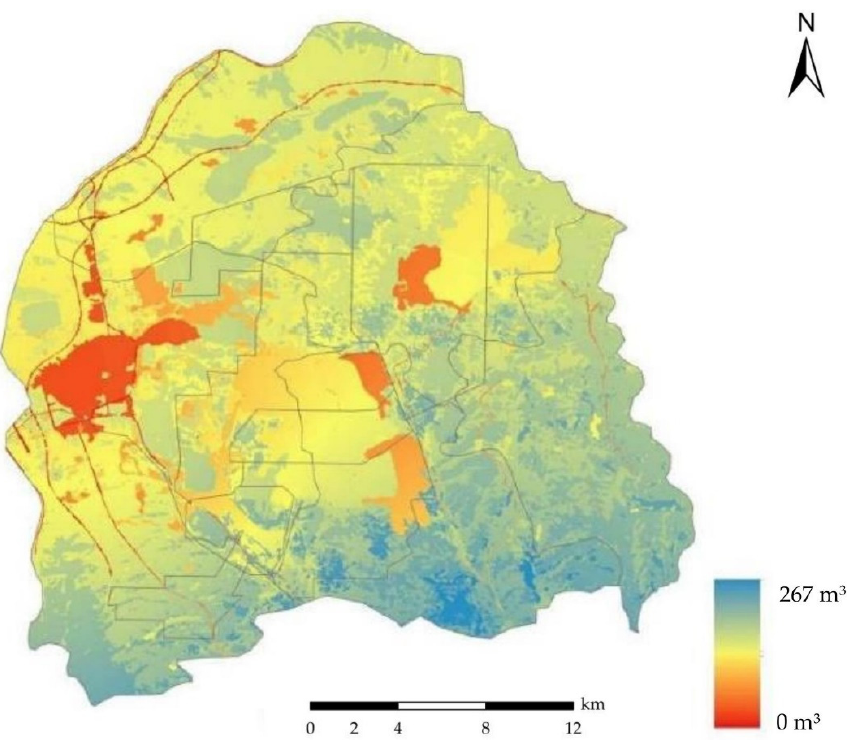
Figure 4. Distribution of WCF in the mine–agriculture–urban compound area.